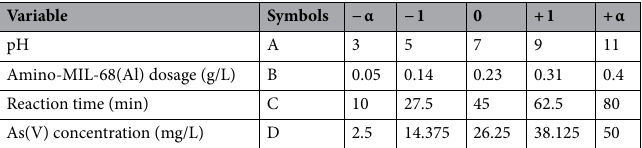
Table 1. Independent variables and their coded levels.